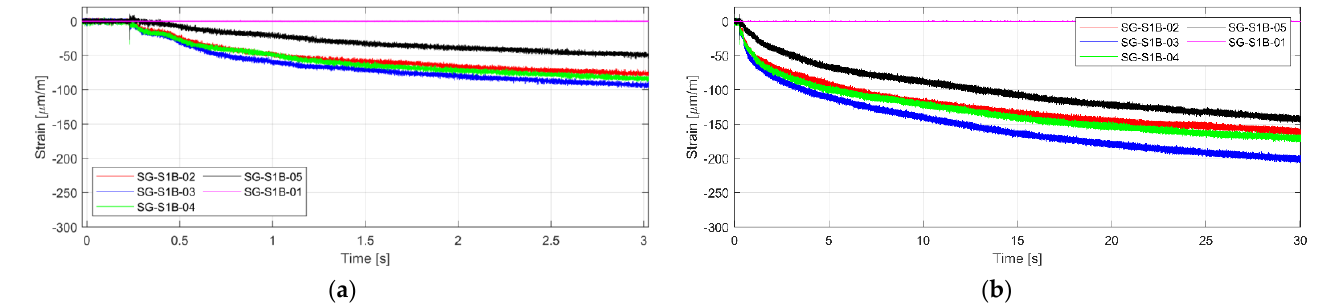
Figure 11. Strain time trends on external surface of S1B reaction vessel. ( a ) zoom on [0–3] s, ( b ) zoom on [0–30] s.